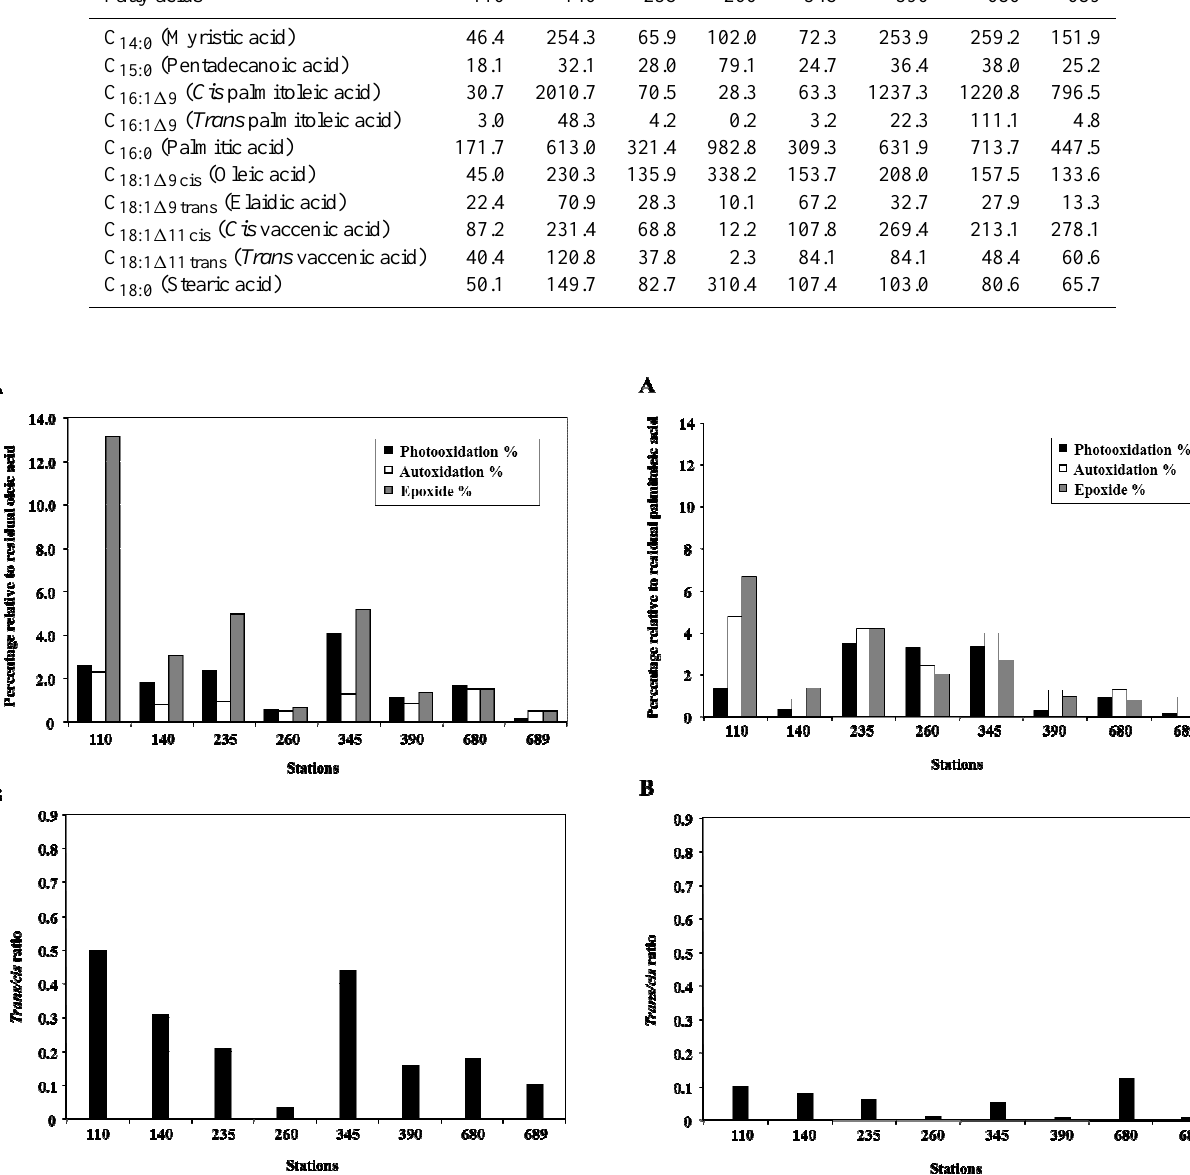
Fig. 7. Estimates of relative autoxidation, photooxidation and epox- ide production (as percentages relative to the residual parent com- pound) (A) and trans / cis ratio measured (B) of palmitoleic acid for the different sediments